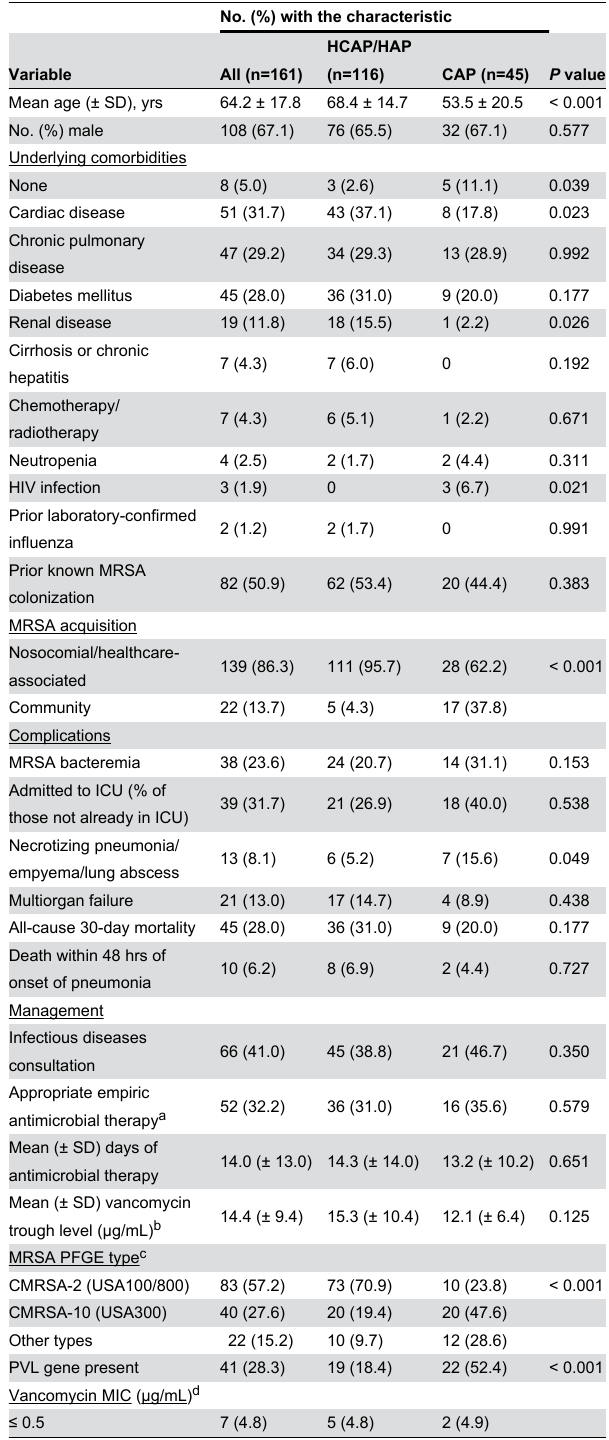
Table 1. Characteristics of patients with healthcare- associated (HCAP),